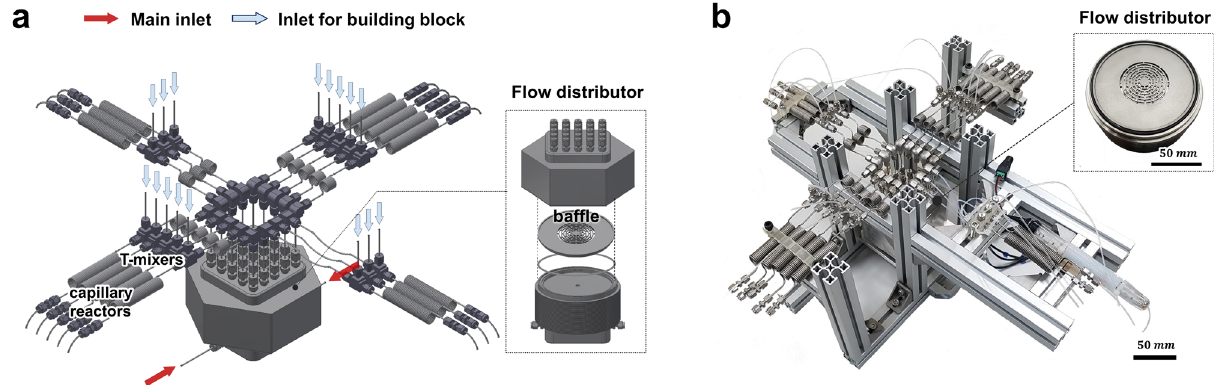
Fig. 2 Flow parallel synthesizer for multiplex synthesis. a Schematic diagram and b photographs of the fl ow parallel synthesizer assembled with 16 capillaries to which the reagent injected by two main inlets at the bottom is uniformly supplied in upward fl ow through a reservoir type of distributor, consecutively merged with diverse building blocks at each T-mixer.